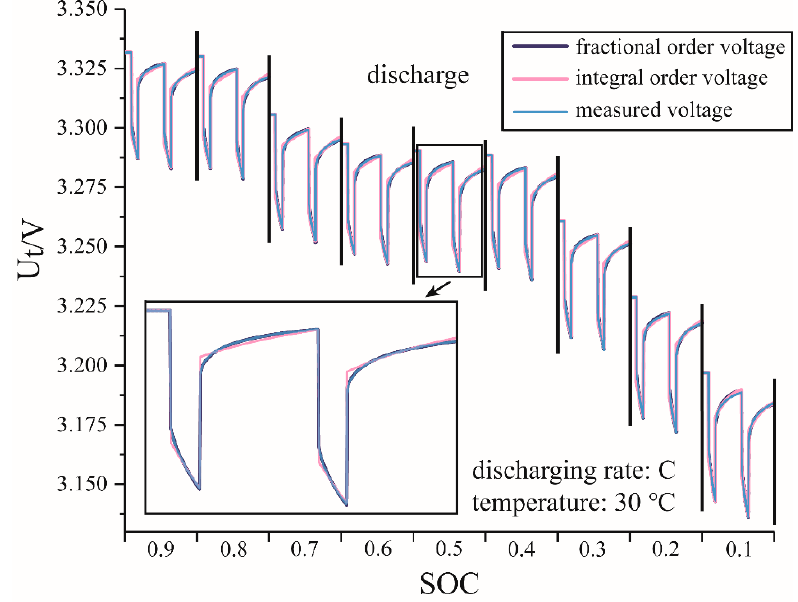
Figure 9. Terminal voltage fitting results from discharging identification test at 30 ℃ in different SOC.